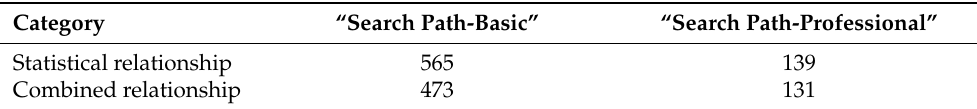
Table 7. The average node degree of knowledge associations between “health” and “3d printing” with two different